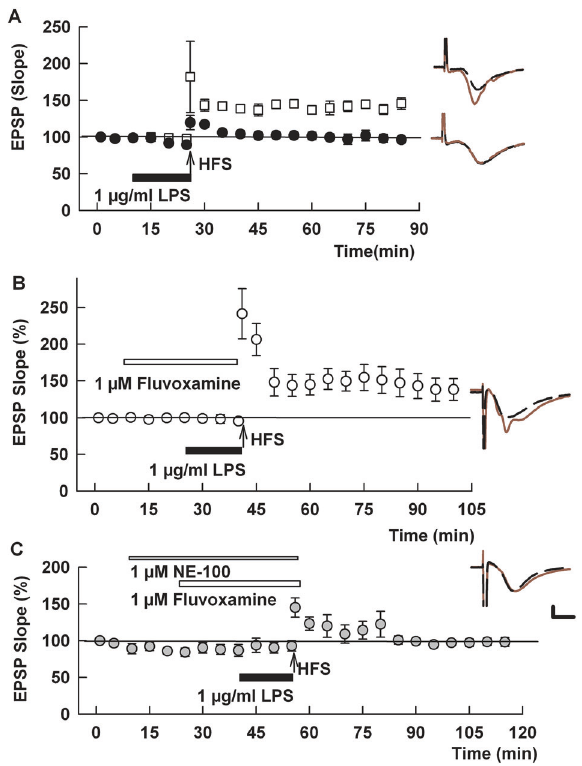
Fig. 1 Fluvoxamine overcomes LPS-induced LTP inhibition. A In control hippocampal slices, a single 100 Hz × 1 s HFS (arrow) readily induces LTP (white squares). Fifteen-minute administration of 1 μ g/ ml LPS (black bar) just prior to HFS completely inhibits LTP (black circles). B When administered for 30 min prior to and during LPS, fl uvoxamine (white bar) prevented the effects of LPS on LTP. C NE- 100 (gray bar), a selective S1R antagonist, overcame the effect of fl uvoxamine on LPS-mediated LTP block. Statistical analyses for this and other fi gures are provided in the text and Supplemental Table 1. Traces to the right of the graphs in this and all fi gures show representative EPSPs at baseline (dashed traces) and 60 in the following HFS (solid red traces). Calibration: 1 mv, 5